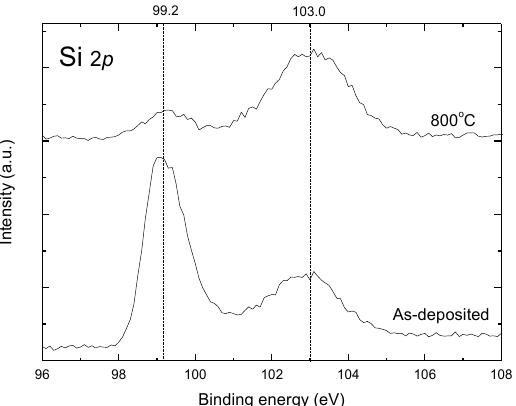
Figure 5. The Si 2 p core levels XPS spectra of the as-deposited and 800 °C annealed SrTiO 3 thin films at the etching time of 960 s.